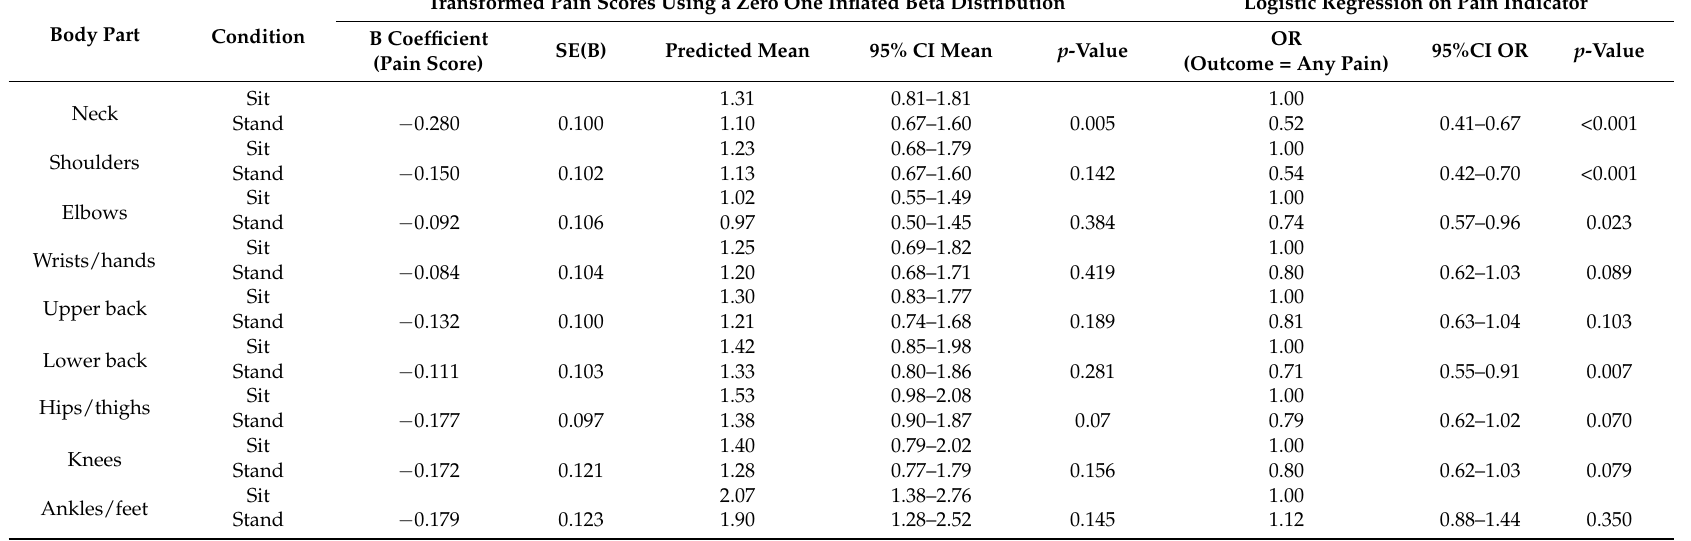
Table 2. Comparison of B coefficients, predicted mean and odds ratios between standing desk and seated desk